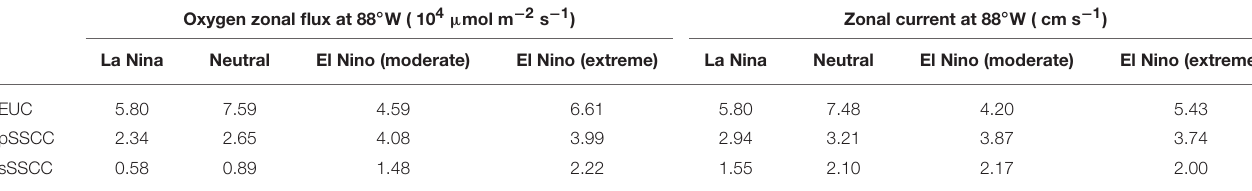
TABLE 2 | DO mean zonal fluxes (in 10 4 µ mol m − 2 s − 1 ) and intensity of the zonal currents (in cm s − 1 ) from the EUC, pSSCC, and sSSCC during LN, Neutral and, moderate and extreme EN periods.